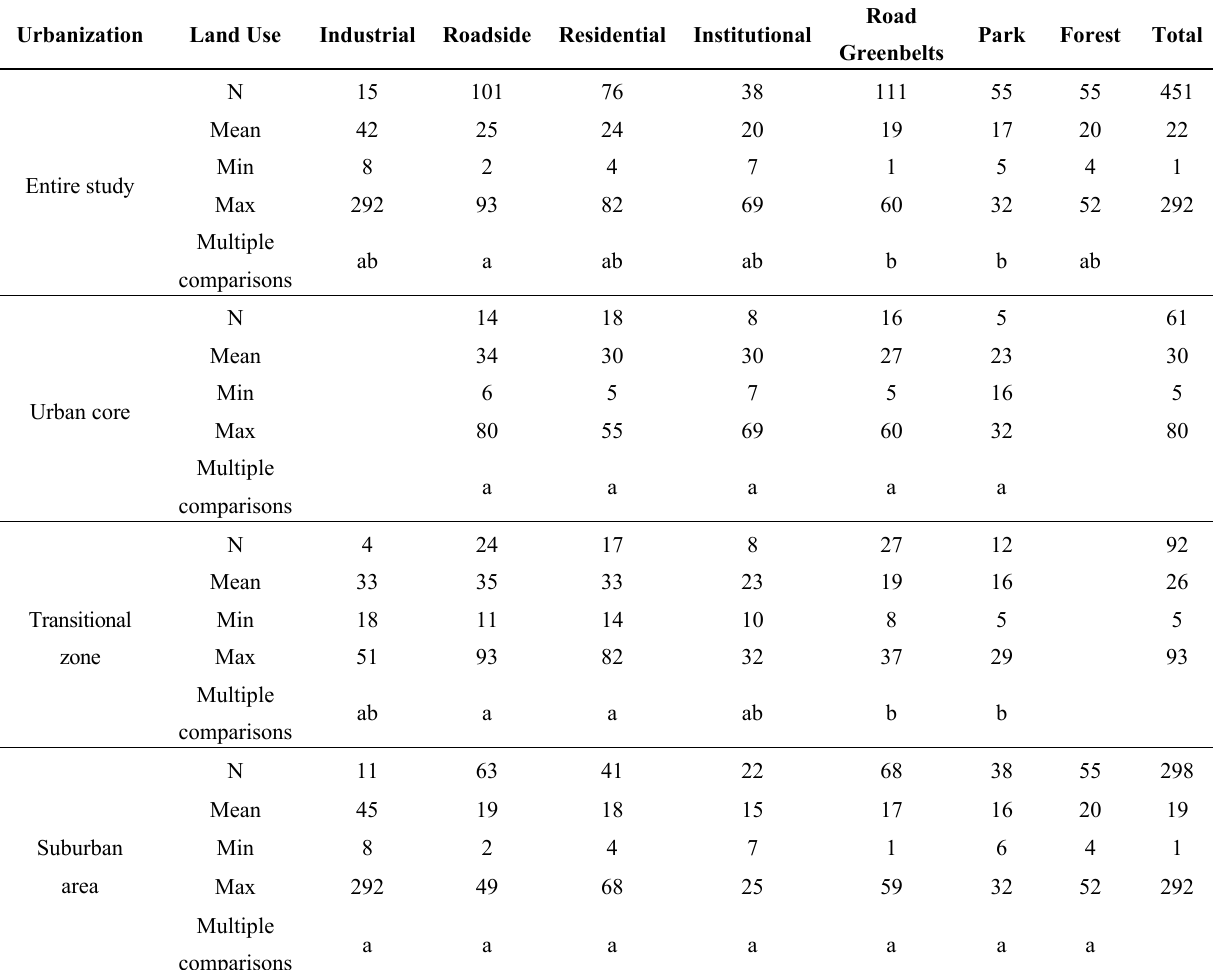
Table 3. Descriptive statistic and Kruskal-Wallis Test of soil lead (mg/kg) for different land uses in urban core, transitional zone and suburban